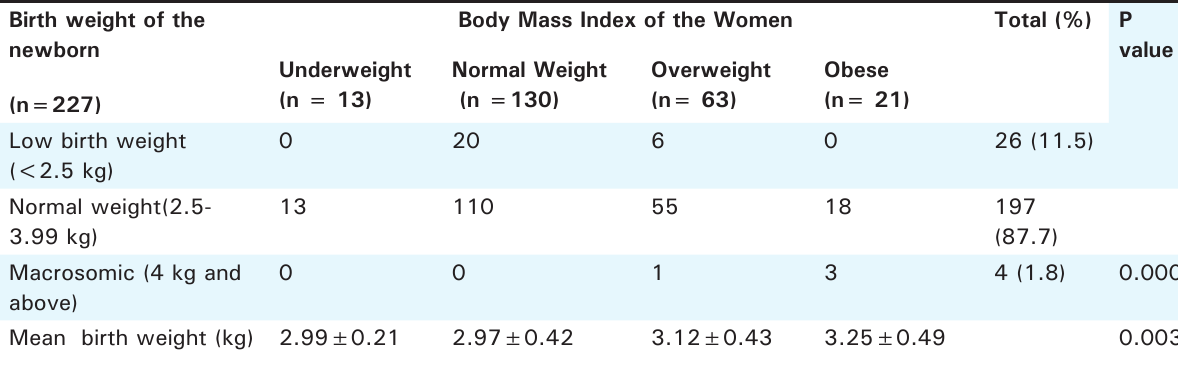
Table 3. Birth weight of the newborn according to BMI of the women. Birth weight of